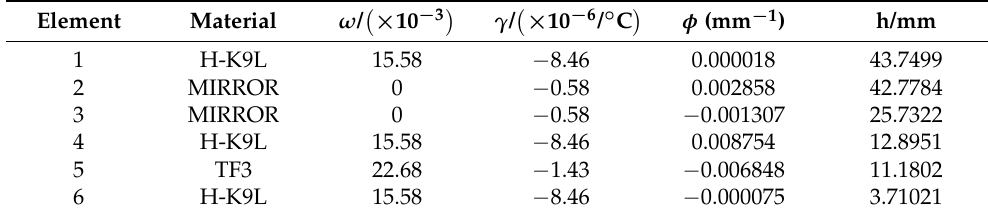
Table 1. Optical properties of elements in the initial optical system.